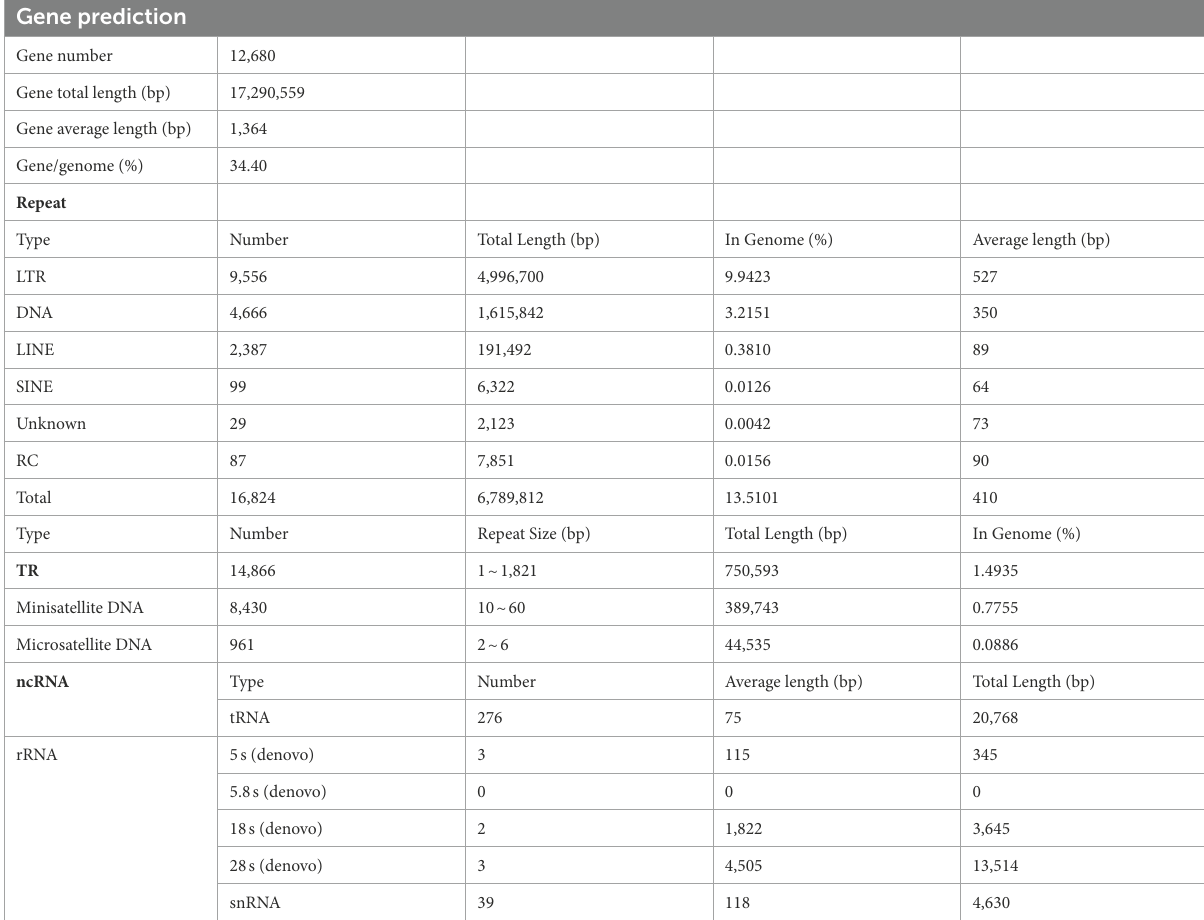
TABLE 6 Genomic component statistics and transposable element repeat class analysis of Rhizopus oryzae strain Y5. Gene